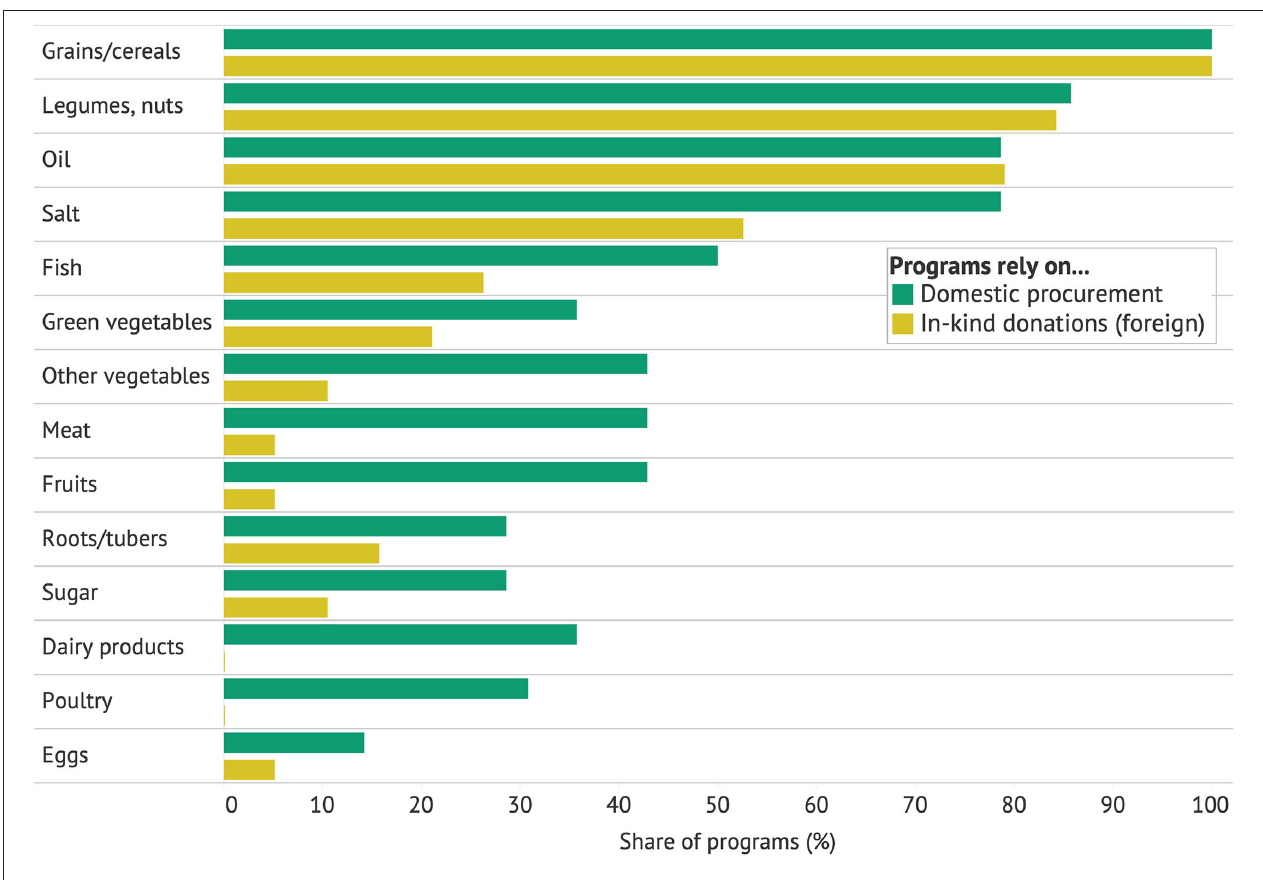
FIGURE 3 | Food basket contents and avenue of food procurement in school meal